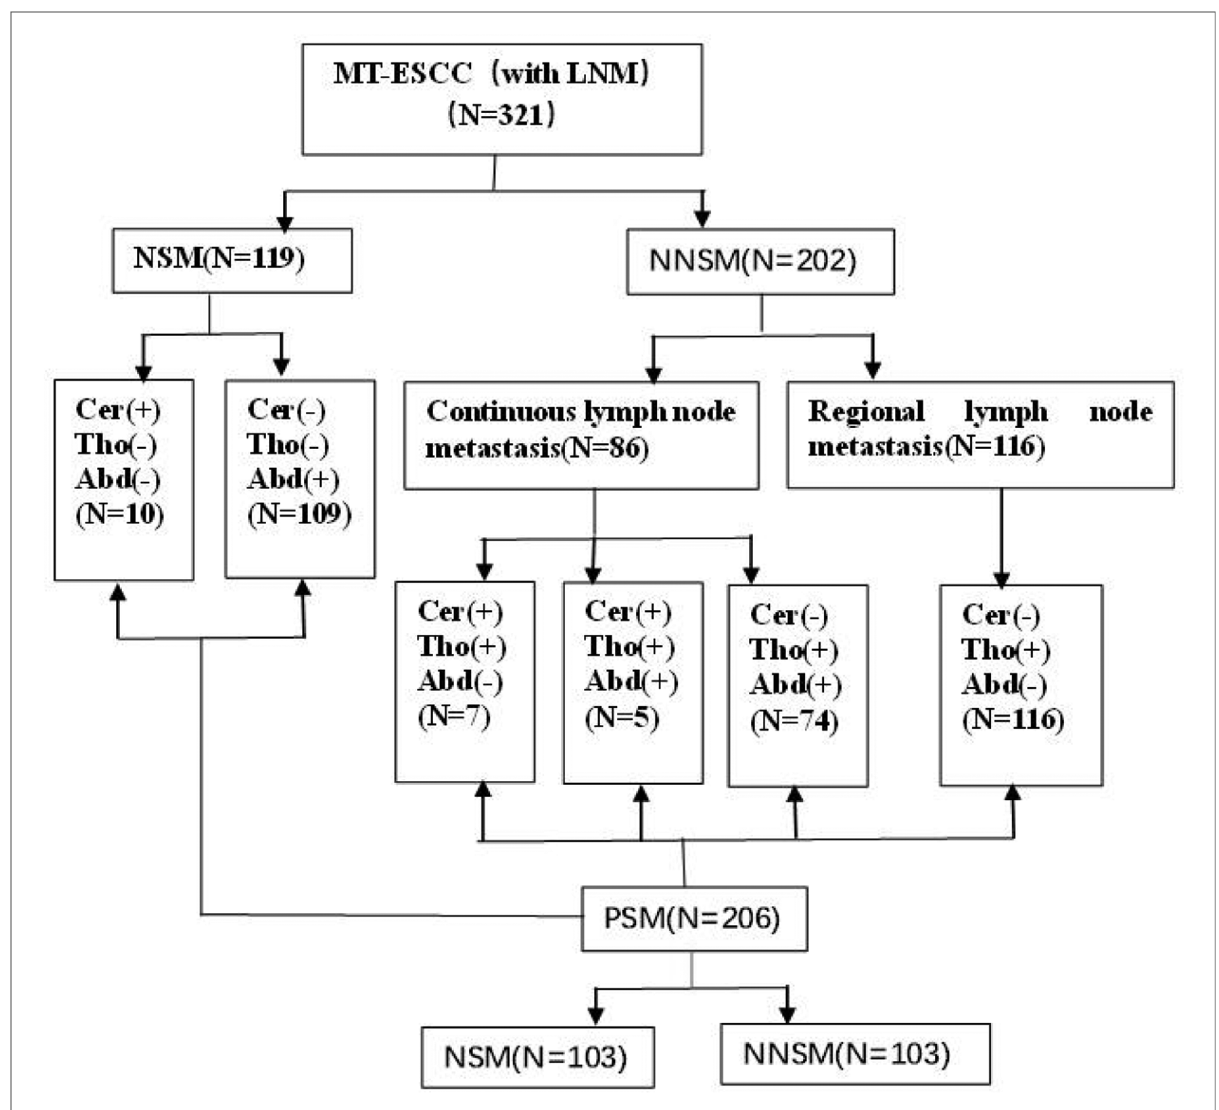
FIGURE 1 Overview of patient selection and grouping. Note: Cer: cervical; Tho: thoracic; Abd: abdominal; LNM: lymph node metastasis; MT-ESCC: mid- thoracic esophageal squamous cell cancer; NSM: nodal skip metastasis; NNSM: no-nodal skip metastasis; PSM: propensity score